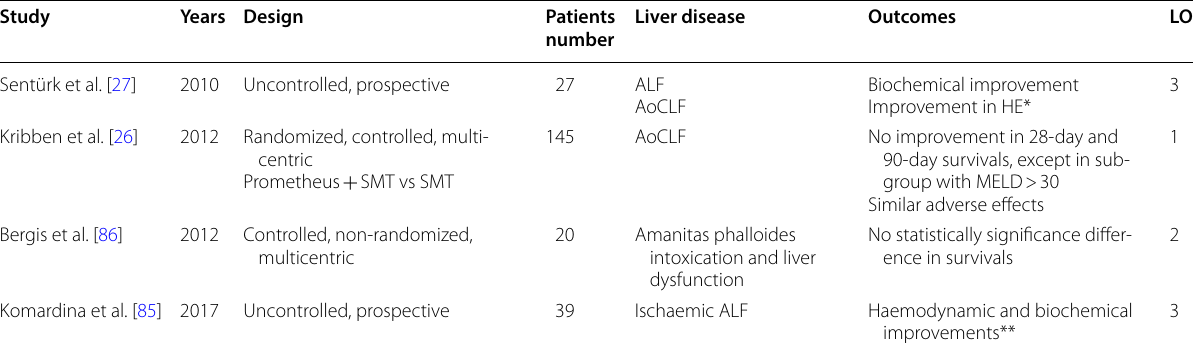
Table 5 Studies with clinical endpoints using Prometheus